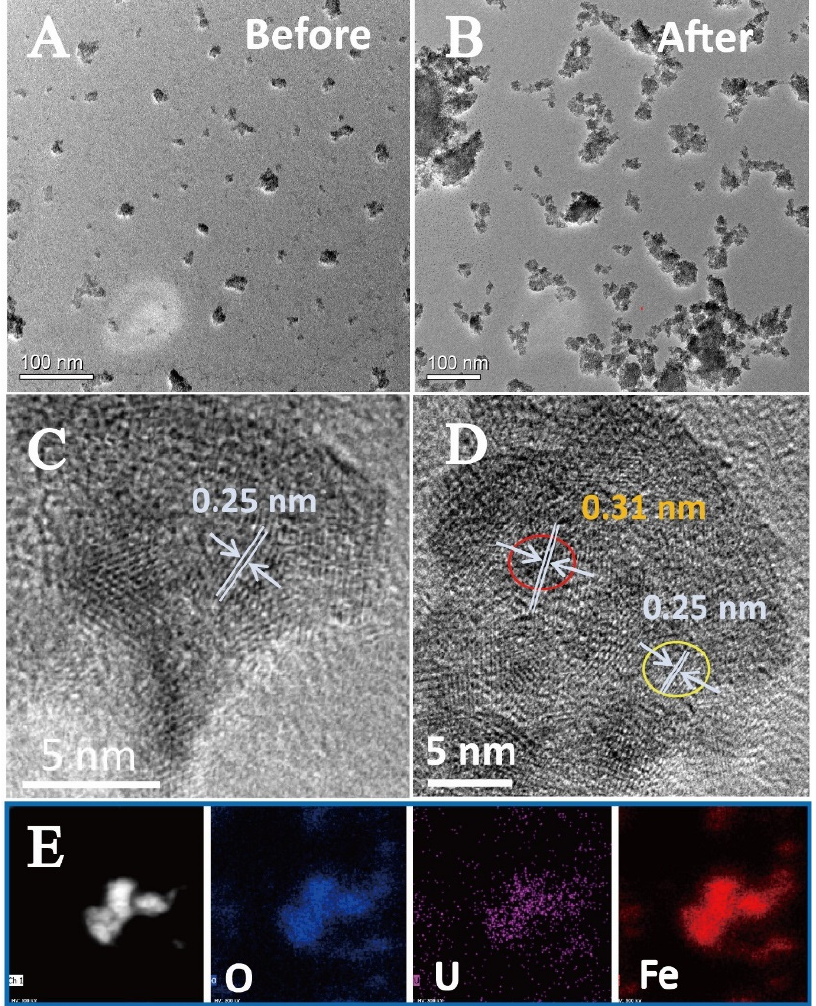
Figure 3. TEM images of ferrihydrite before ( A , C ) and after the photocatalytic reactions ( B , D ), and the element mapping of uranium loaded ferrihydrite ( E